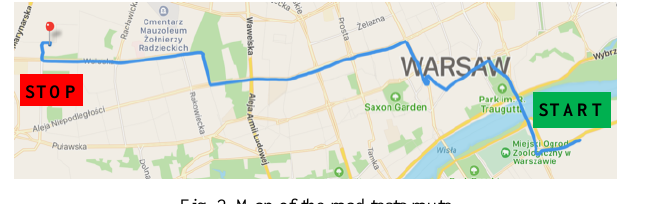
Fig. 2. Map of the road tests route